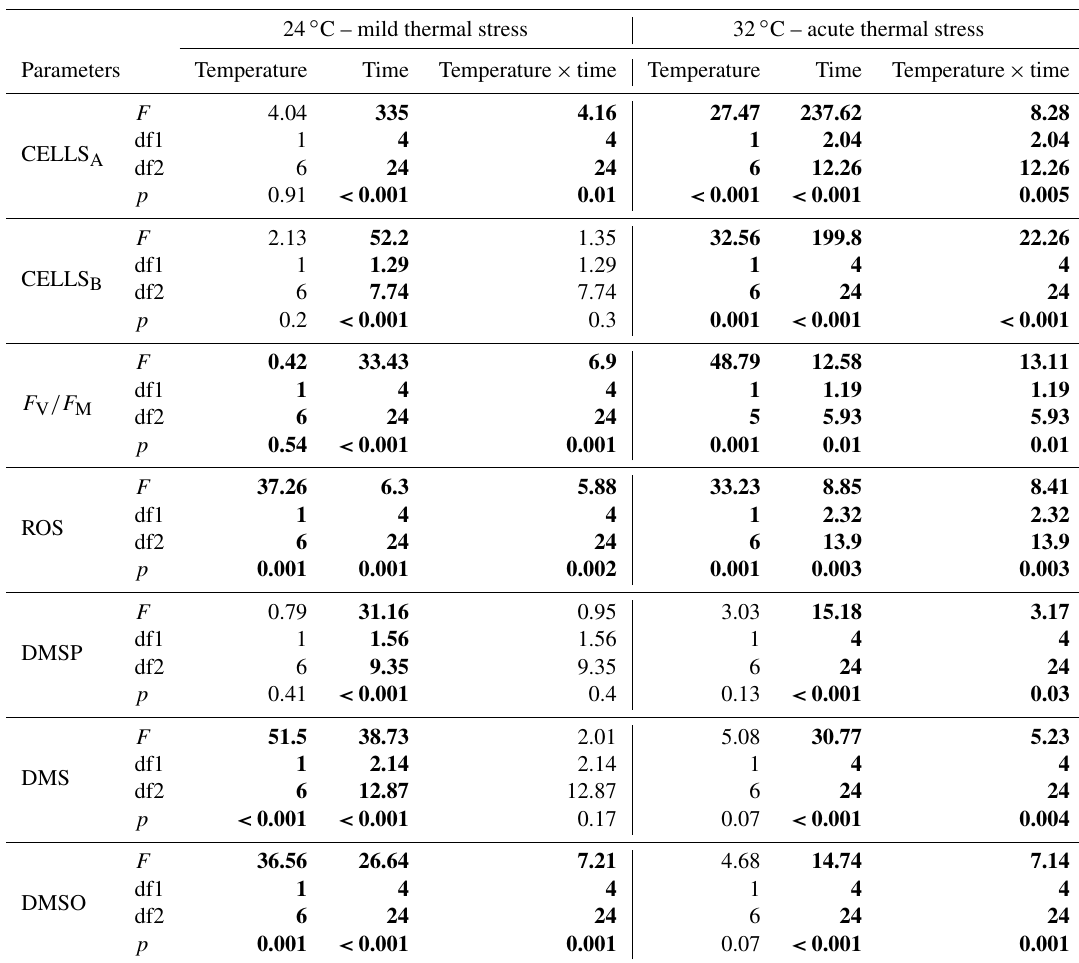
Table 1. Output of repeated measures analysis of variance (rmANOVA) for algal (CELLS A ) and bacterial (CELLS B ) cell abundance, photo- synthetic efficiency ( F V /F M ), oxidative stress (ROS), dimethyl sulfoniopropionate (DMSP), dimethyl sulfide (DMS) and dimethyl sulfoxide (DMSO) concentrations as a function of temperature (24 or 32 ◦ C) and time. Numbers in bold indicate significant data based on the level of significance p < 0 . 05. df1 indicates the numerator df, and df2 indicates the denominator